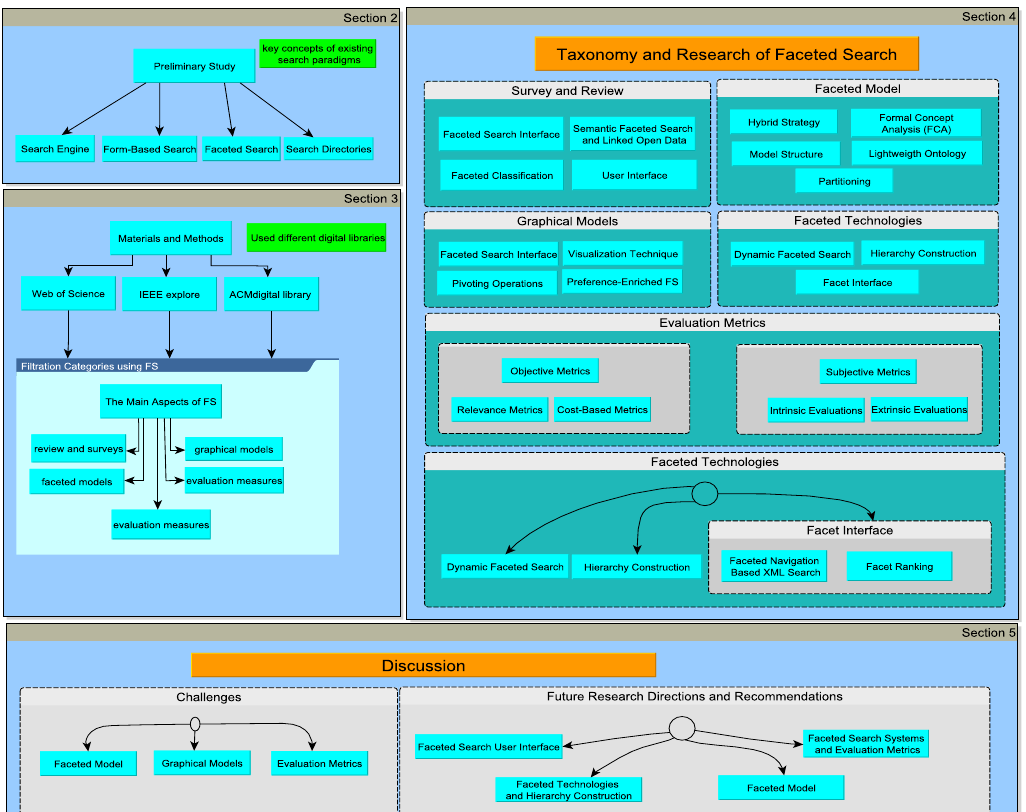
Figure 1. Diagrammatic view of the organization of this survey